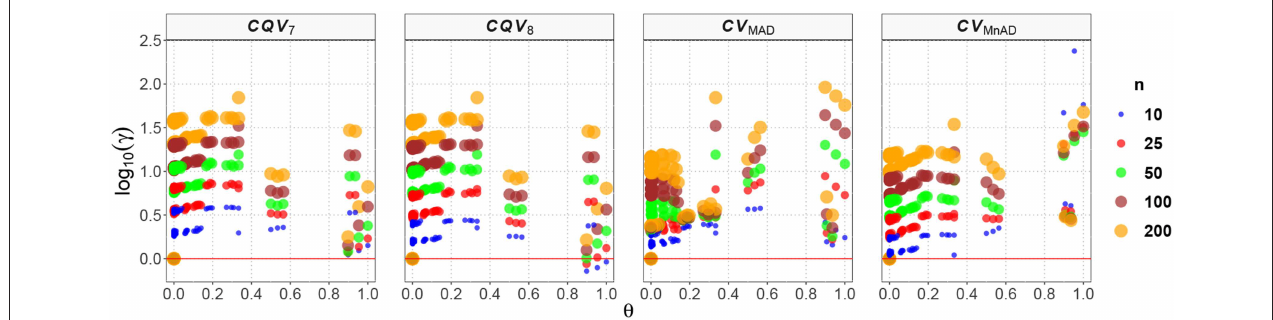
(0,1) produced for each estimator and sample size under the reparametrized ∈